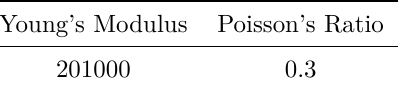
Material behavior assigned in Abaqus (Ductile